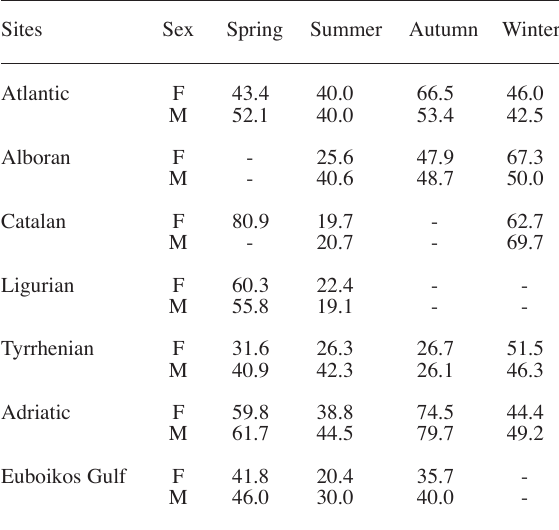
ABLE 2. – Percentage of fullness per site/season in females (F) and males (M). (-)Seasons where samples were not collected.